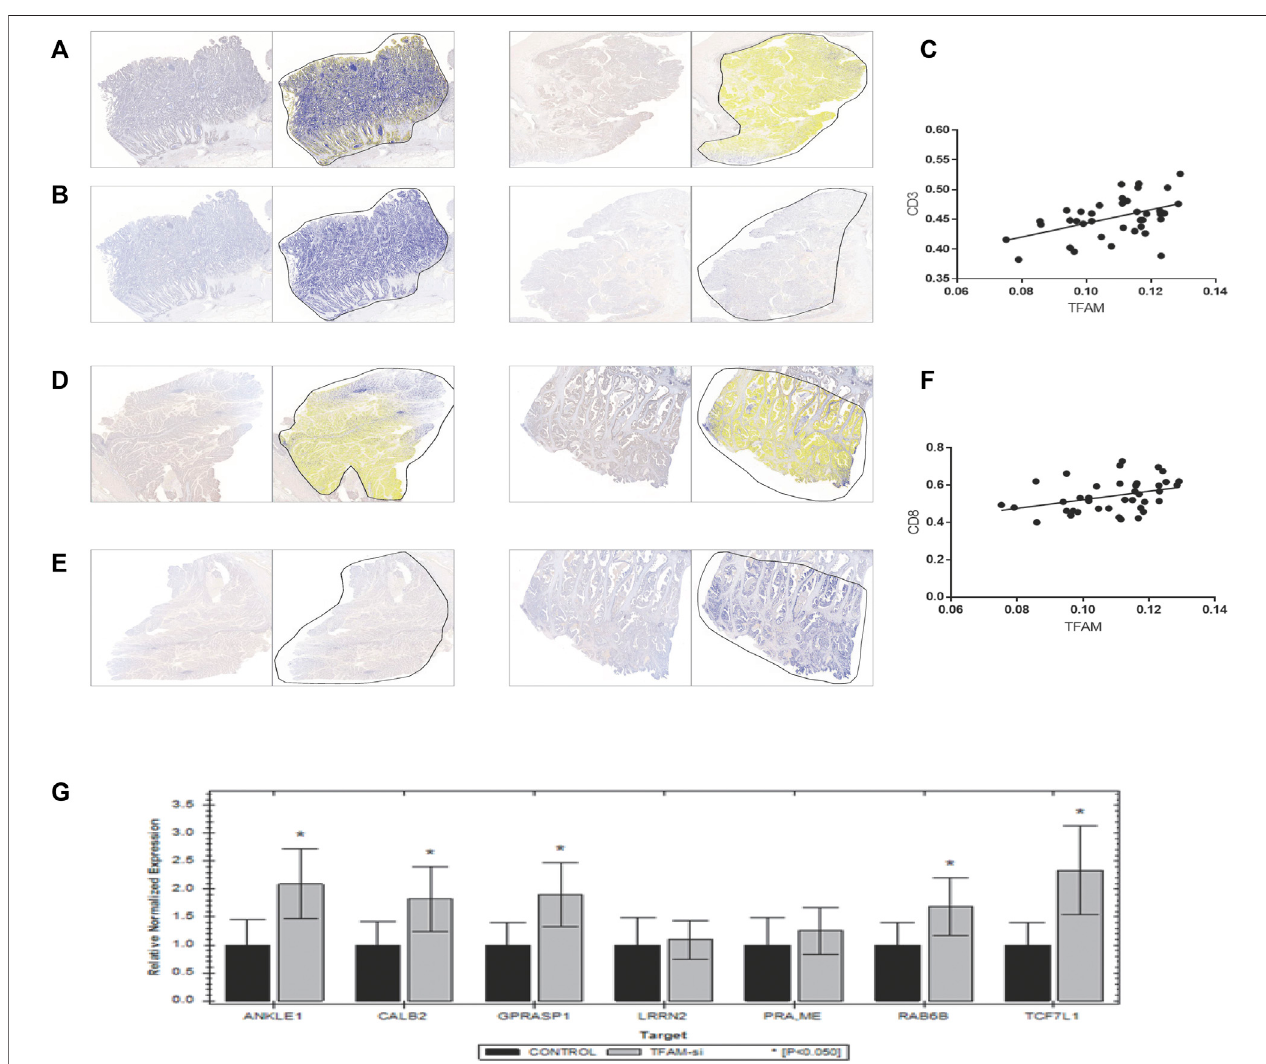
FIGURE 7 | Veri fi cation of the correlation between T-cell in fi ltration and mitochondrial copy number. Results of immunohistochemistry of 39 colon patients are shown here. (A,B,D,E) were paired IHC tissues. As shown in results, tissues with a higher TFAM expression [left of (A,B,D,E) ] have a stronger CD3 [right of (A,B) ] and CD8 [right of (D,E) ] expression. (C,F) shows positive correlation relationship of CD3 and CD8 with the TFAM expression ( p = 0.0031 and 0.0237, respectively). (G) Results of the mRNA expression of seven signature genes in TFAM-knockdown SW480 cells by qPCR.